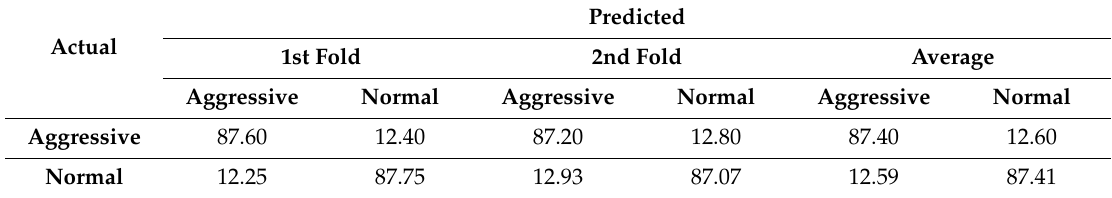
Table 11. Classification accuracies by score level fusion while using the AlexNet model [53] (%). Predicted Actual 1st Fold 2nd Fold Normal Aggressive